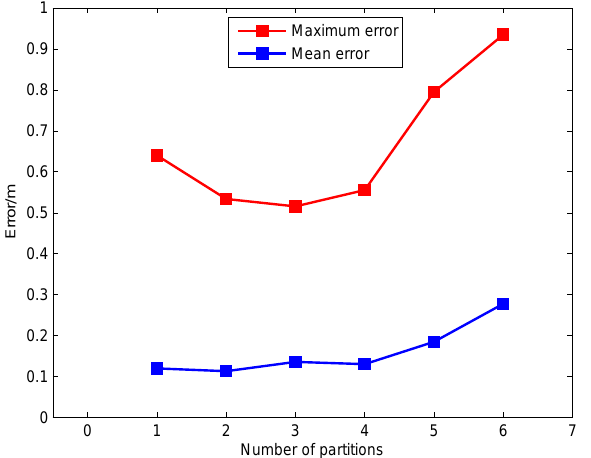
Figure 9. The mean error and maximum error of location estimation by different RP partition numbers.